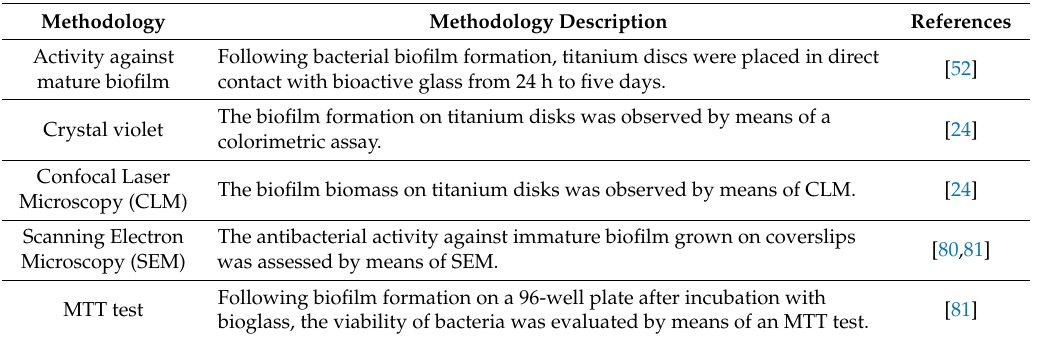
Table 3. Antibiofilm activity of bioglass. Table shows the main quantitative and qualitative methods to assess the antibiofilm activity of different types of bioactive